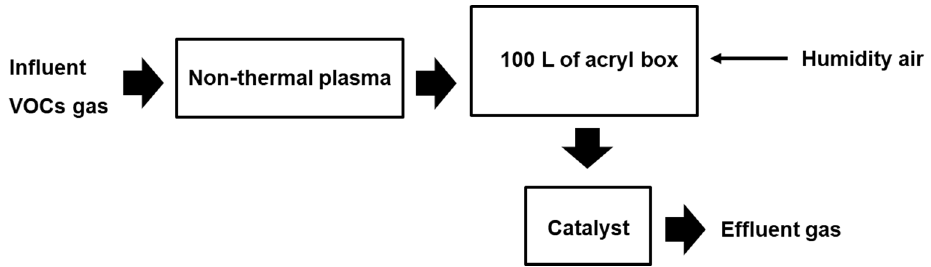
Figure 8. A schematic illustration of a non-thermal plasma (NTP)/catalyst hybrid reactor system for the VOCs decomposition from food waste.